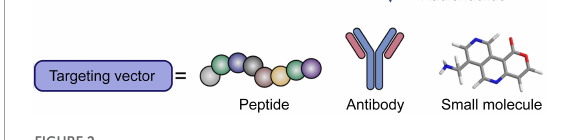
FIGURE2 Schematic representation of radiopharmaceutical for targeted alpha therapy. The main targeting vectors are peptides, antibodies, and small molecules. Modified with permission